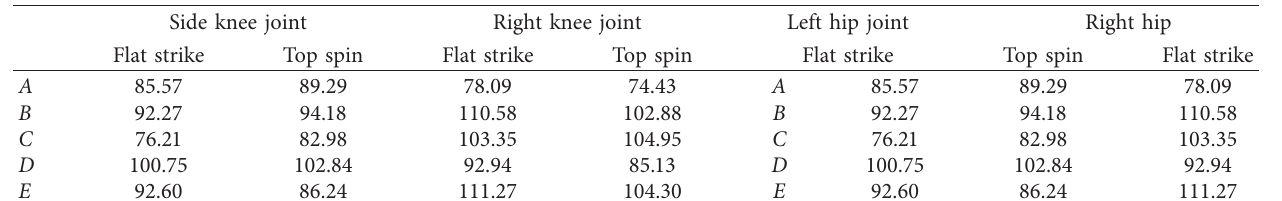
Table 3: Comparison table of smallest angles of the knee and hip joints at the racket stage (unit: ° ).